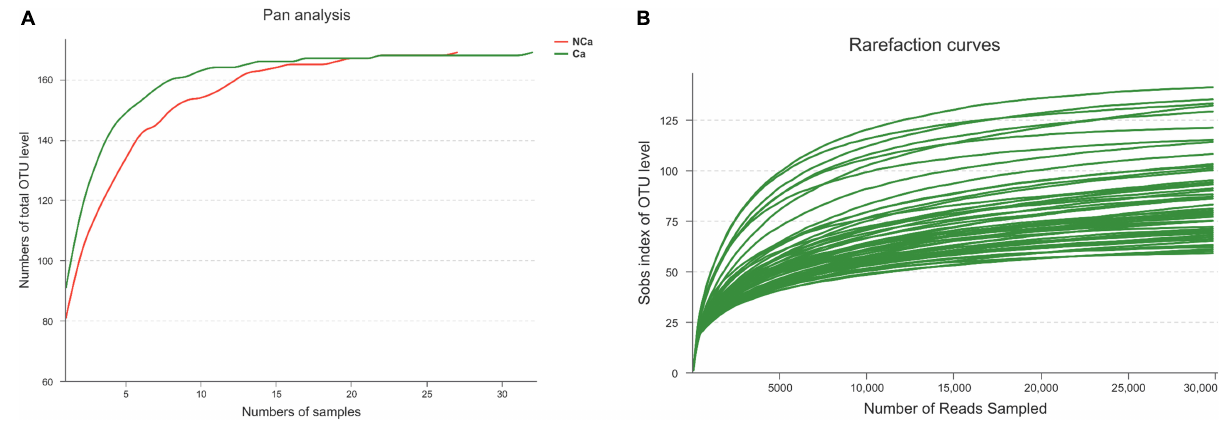
Frontiers in Microbiology |